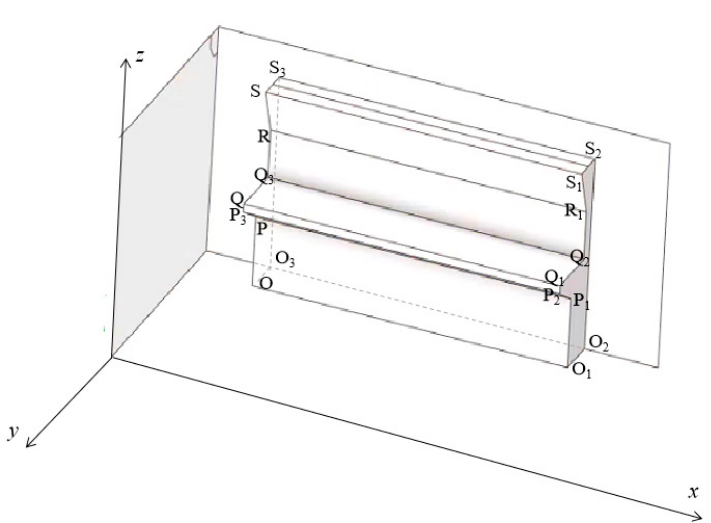
Figure 3. The corresponding letters of the display and control console. Table 3. T he corresponding coordinates of each letter in the display and control console.